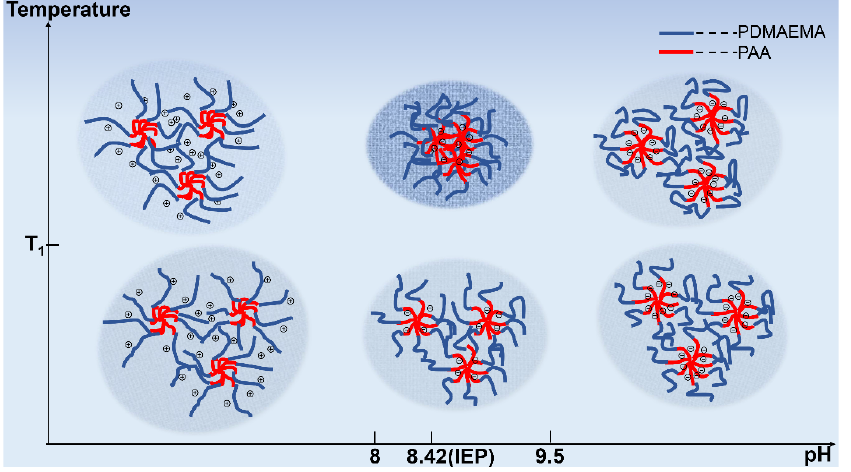
Figure 5. Schematic diagram of the pH- and thermo-response of the star-like PAA 1 - b -PDMAEMA 4 solution.